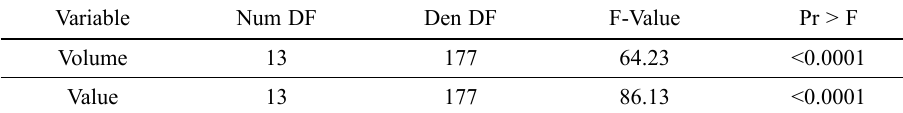
Table 2. Test F, volume and value